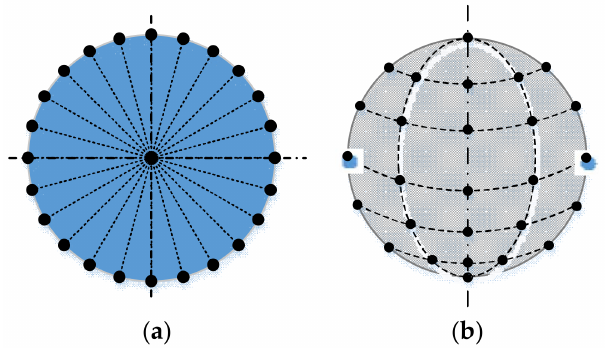
Figure 8. Sample strategy of a circle and a sphere: ( a ) sample points on a circle; ( b ) sample points on a